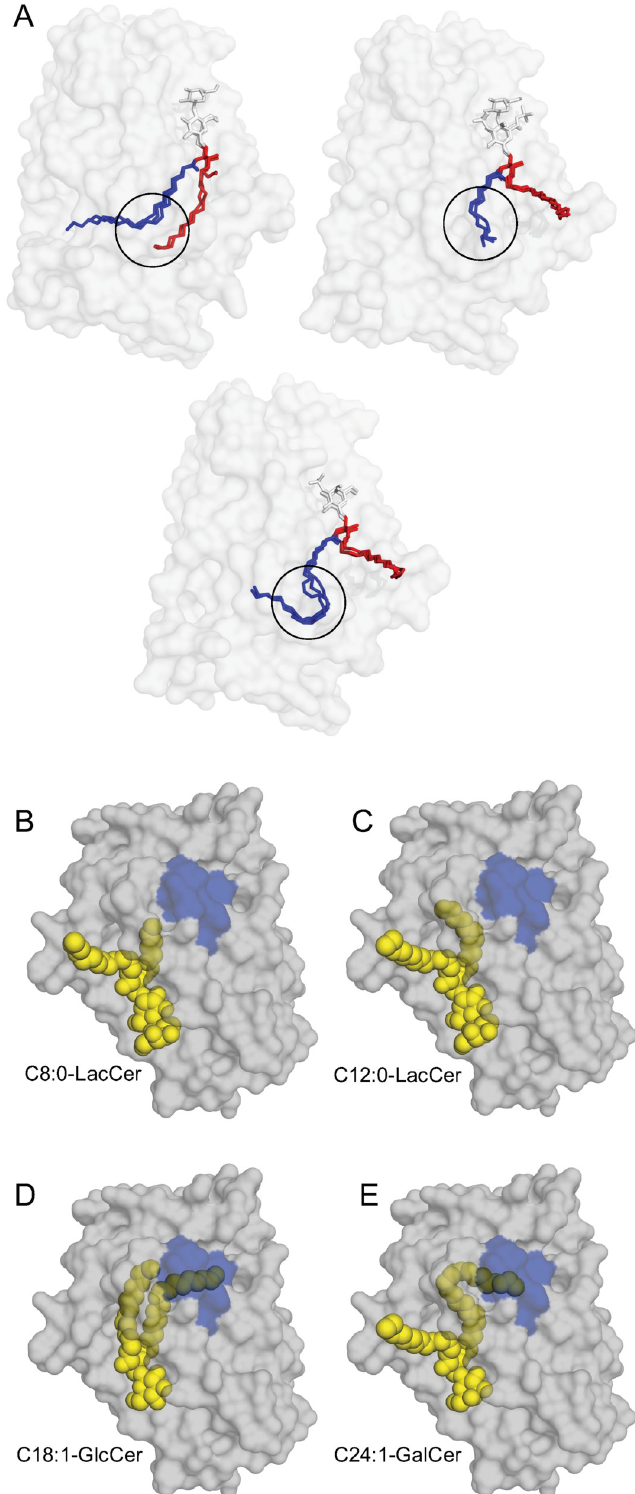
Fig 7. Glycosphingolipid N-linked acyl chain binding in GLTP crystal structures. (A) To the left bound C18:1-GlcCer, C18:0-LacCer and ganglioside GM3 lipids in the sphingosine-in conformation found in the crystal structures of different GLTPs (3S0K, 1SX6 and 2BV7 respectively). On the right is bound